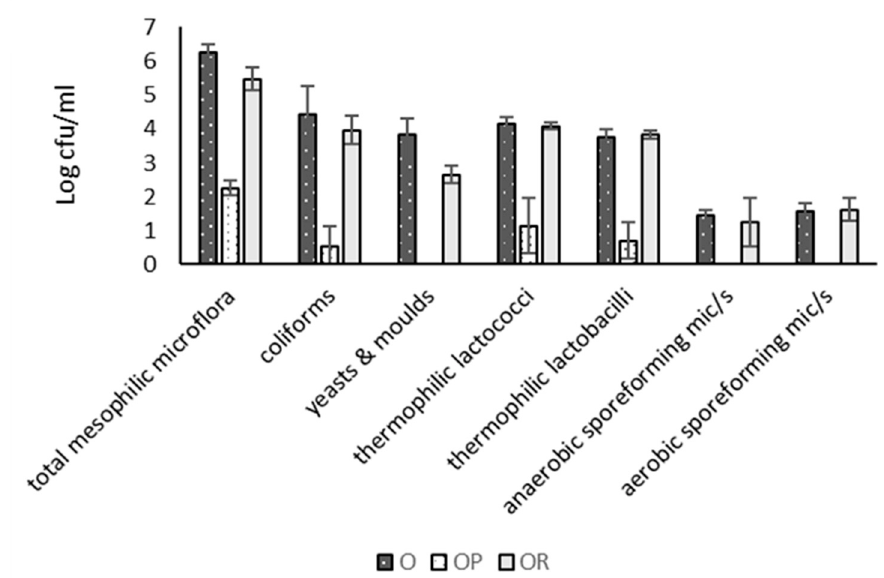
Figure 2. E ff ect of microfiltration on microbial counts (Log cfu.mL − 1 ) of partially defatted bovine (B) or ovine (O) milk, bovine permeate (BP), bovine retentate (BR) (mean ± SD, n = 3), ovine permeate (OP) and ovine retentate (OR) (mean ± SD, n = 5).